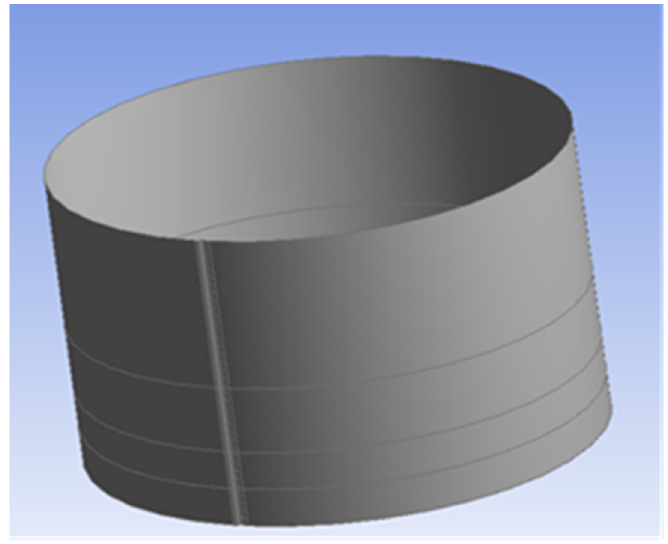
Figure 5. General view of the tank, taking into account the field joint [61].